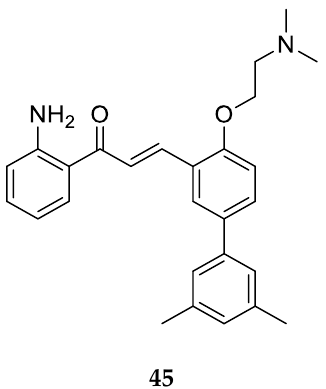
Figure 28. Chemical structure of the 2-aminochalcone derivative with substitution on ring B.